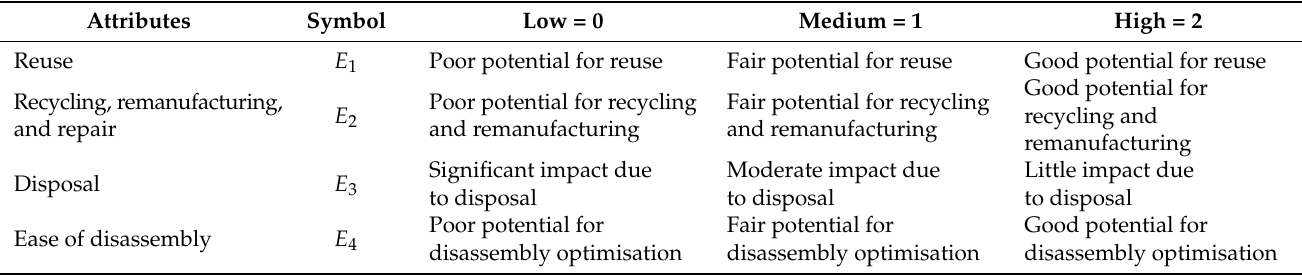
Table 6. Attributes for measuring concept end-of-life sustainability.